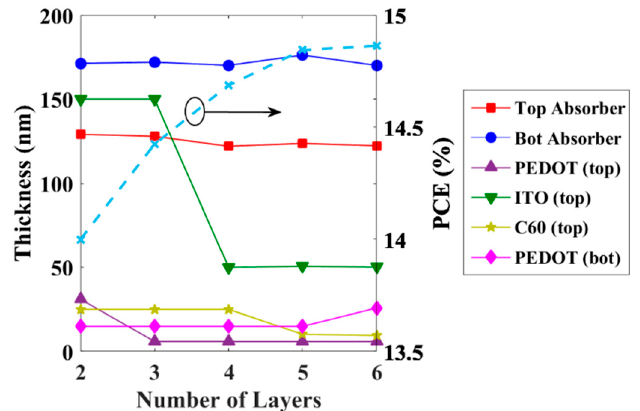
Figure 10. Evaluation of PCE upon layer thickness optimization vs. the number of layers taken in global optimization routines.